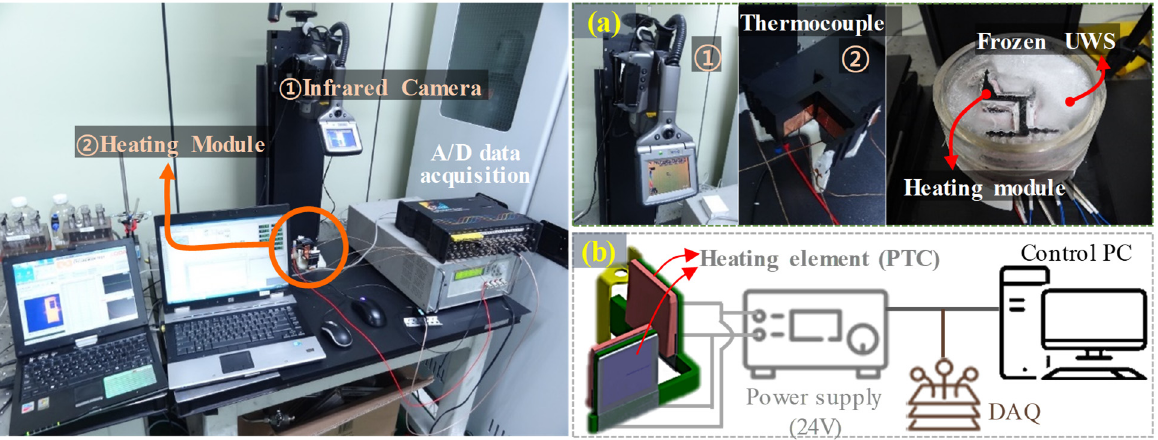
Figure 2. Experimental setup for urea melting test: ( a ) thermal melting characteristics; ( b ) heater power supply.